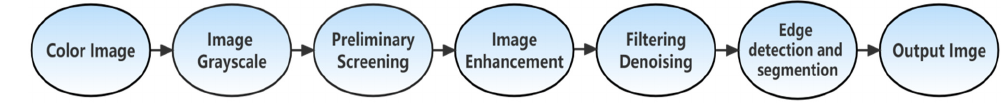
Figure 1. Image pre-processing Figure 1. Image pre ‐ processing process.